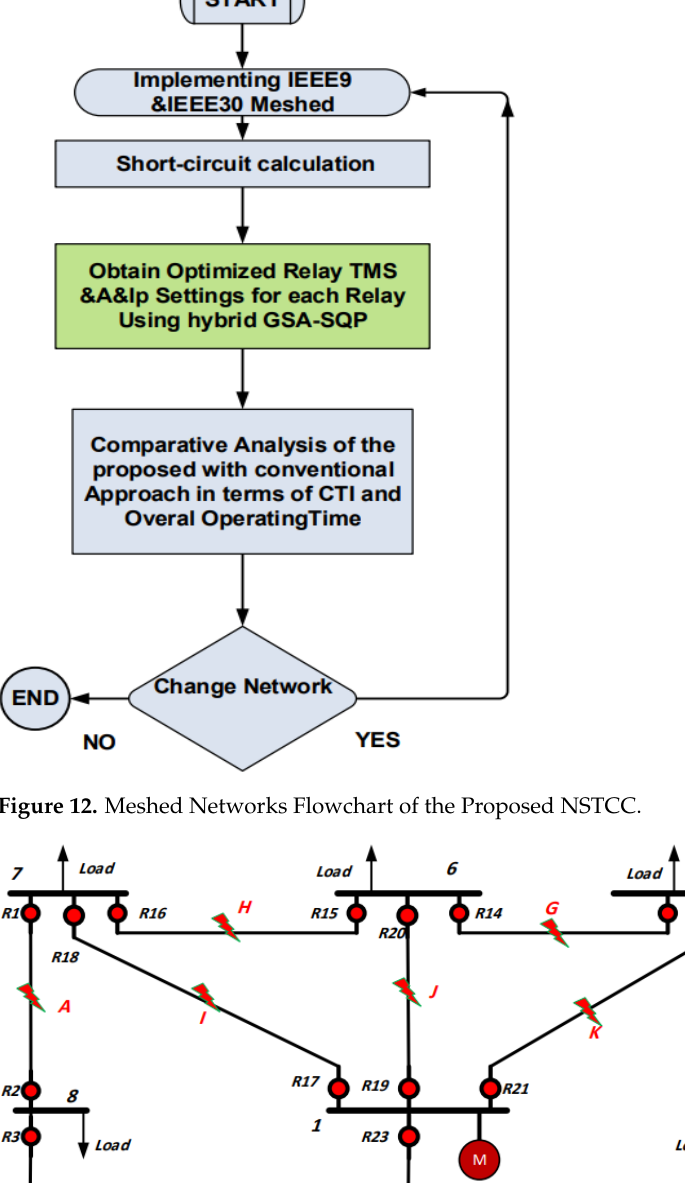
Table 9. CTI for the Meshed 9-bus Test System.